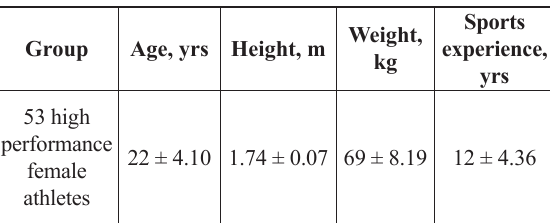
Table. Characteristics of the study group